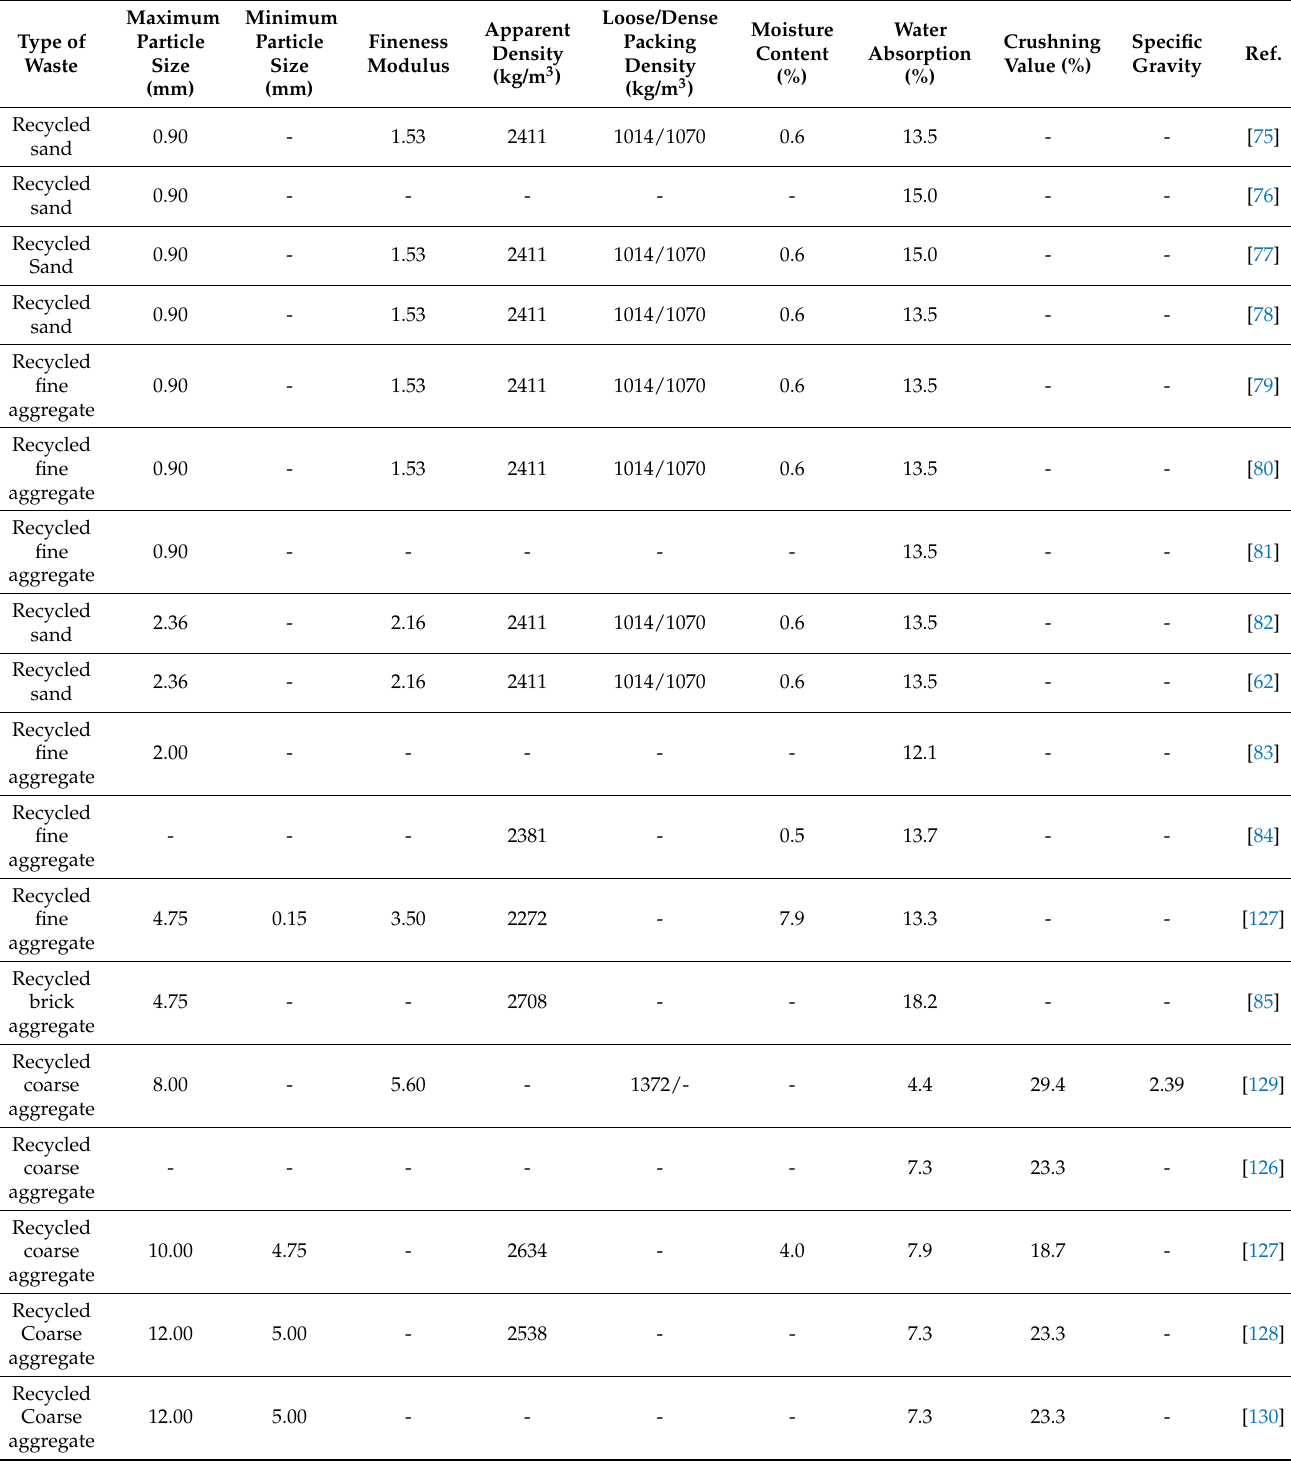
Table 6. Physical properties of different recycled aggregates from CDW used in 3DPCC